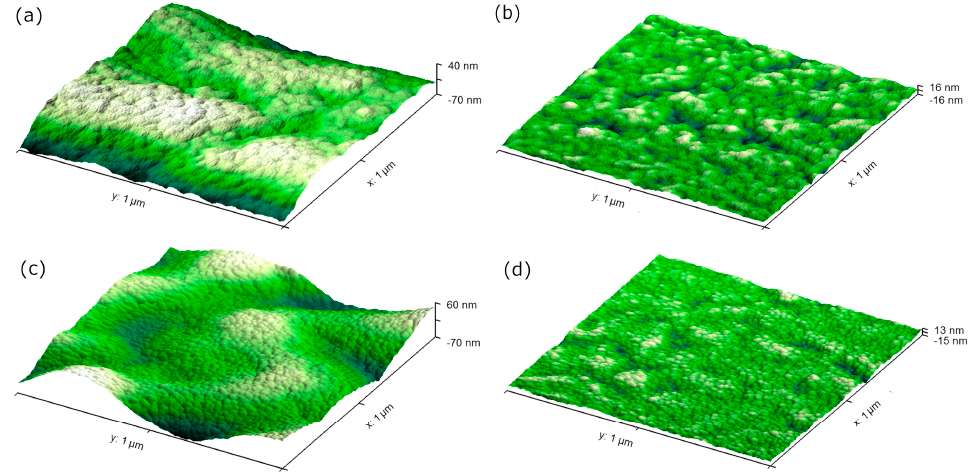
Figure 1. 3D AFM images of Ag/AZO coatings on PLA before (left) and after (right) fine correction: ( a ) and ( b ) Ag(RFS)/AZO; ( c ) and ( d ) Ag(SCBD)/AZO. For all images, the X:Y:Z scale ratio is 1:1:1.